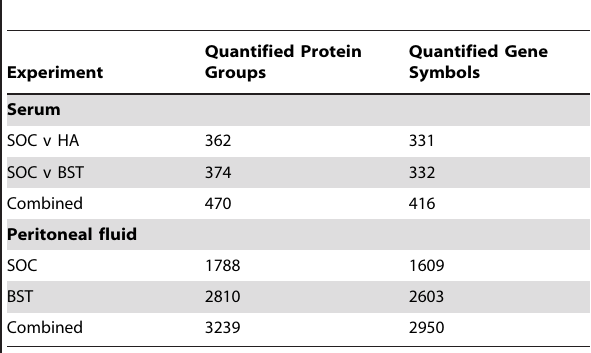
Table 2. Summary of proteins quantified in each